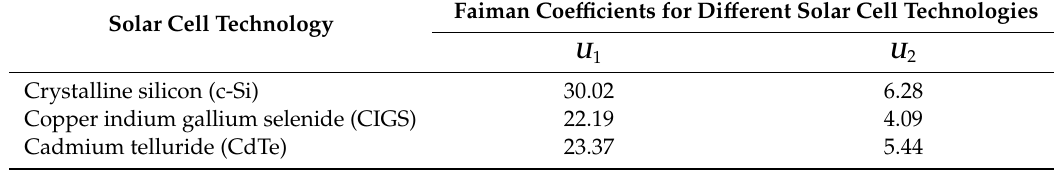
Table 4. Faiman coe ffi cients for solar cell technologies used as a photovoltaic leaf